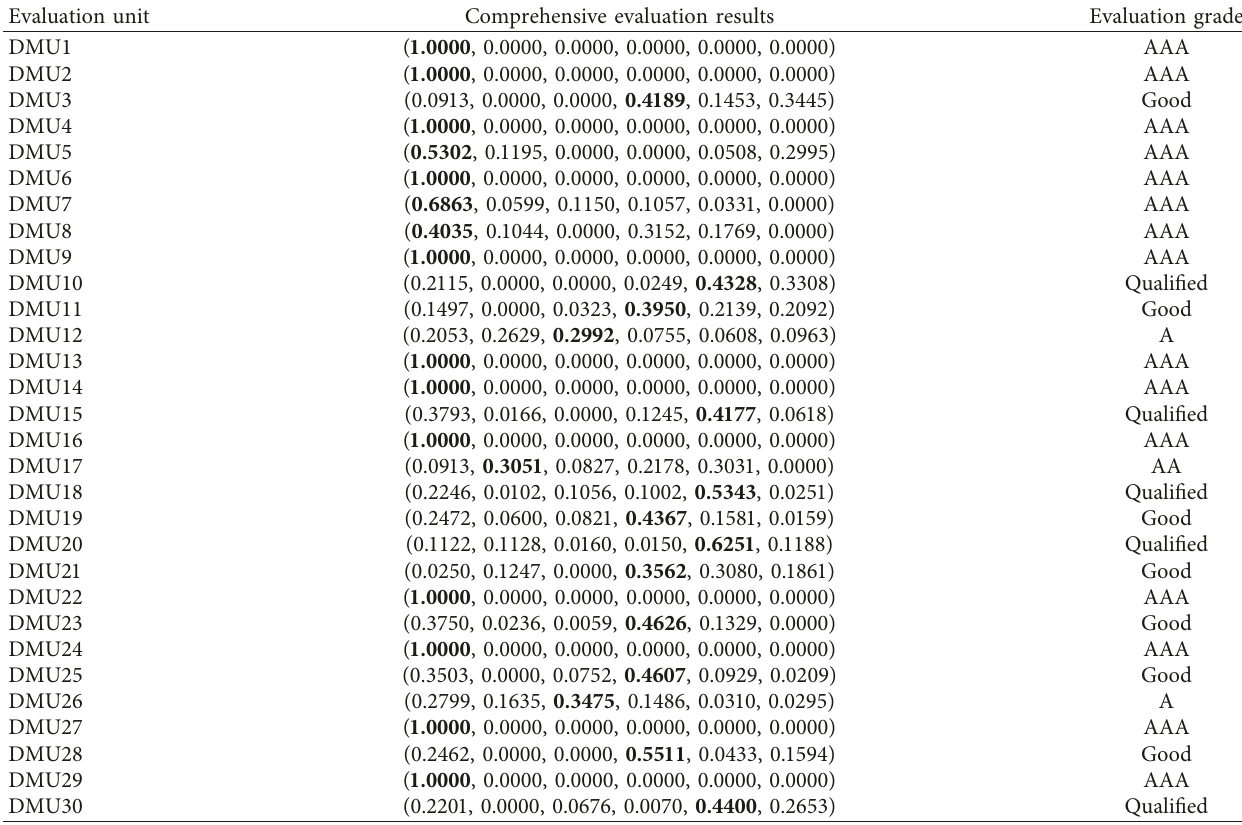
Table 8: Comprehensive evaluation results of construction industrialization enterprises.